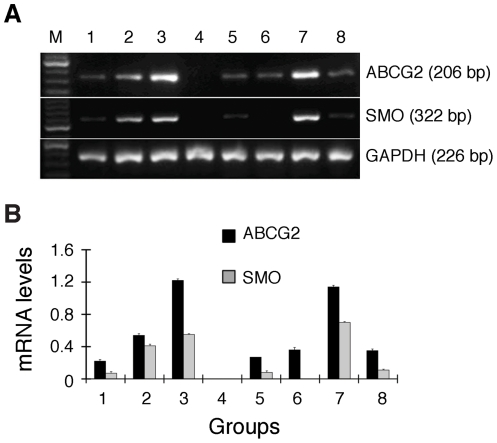
RT-PCR analysis of ABCG2 and SMO mRNA levels.A, Representative RT-PCR gel images. M, marker; lane 1, NCI-H460 cells normally cultured in serum-containing medium; lane 2, the H460 spheres; lane 3, purified SP cells; lane 4, purified non-SP cells; lane 5, the Tomatidine control group; lane 6, the Cyclopamine experimental group; lane 7, SP tumors; lane 8, non-SP tumors. B, Quantitative presentation of ABCG2 and SMO mRNA levels as determined by densitometry (P<0.001, except ABCG2 mRNA lane 6 vs. lane 8 and SMO mRNA lane 1 vs. lane 5 and lane 4 vs. lane 6).